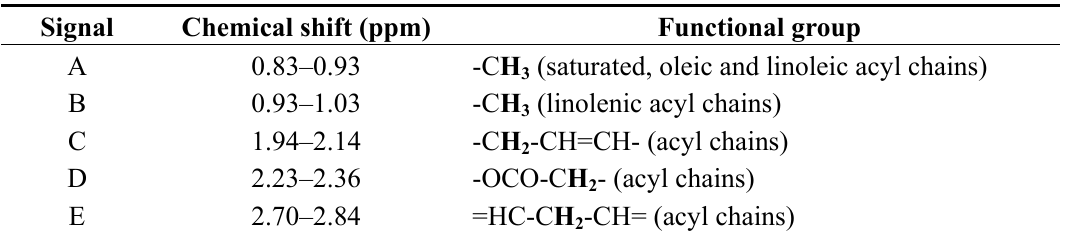
Table 2. Assignment of signals of 1 H-NMR spectra. Signal number agrees with those in Figure